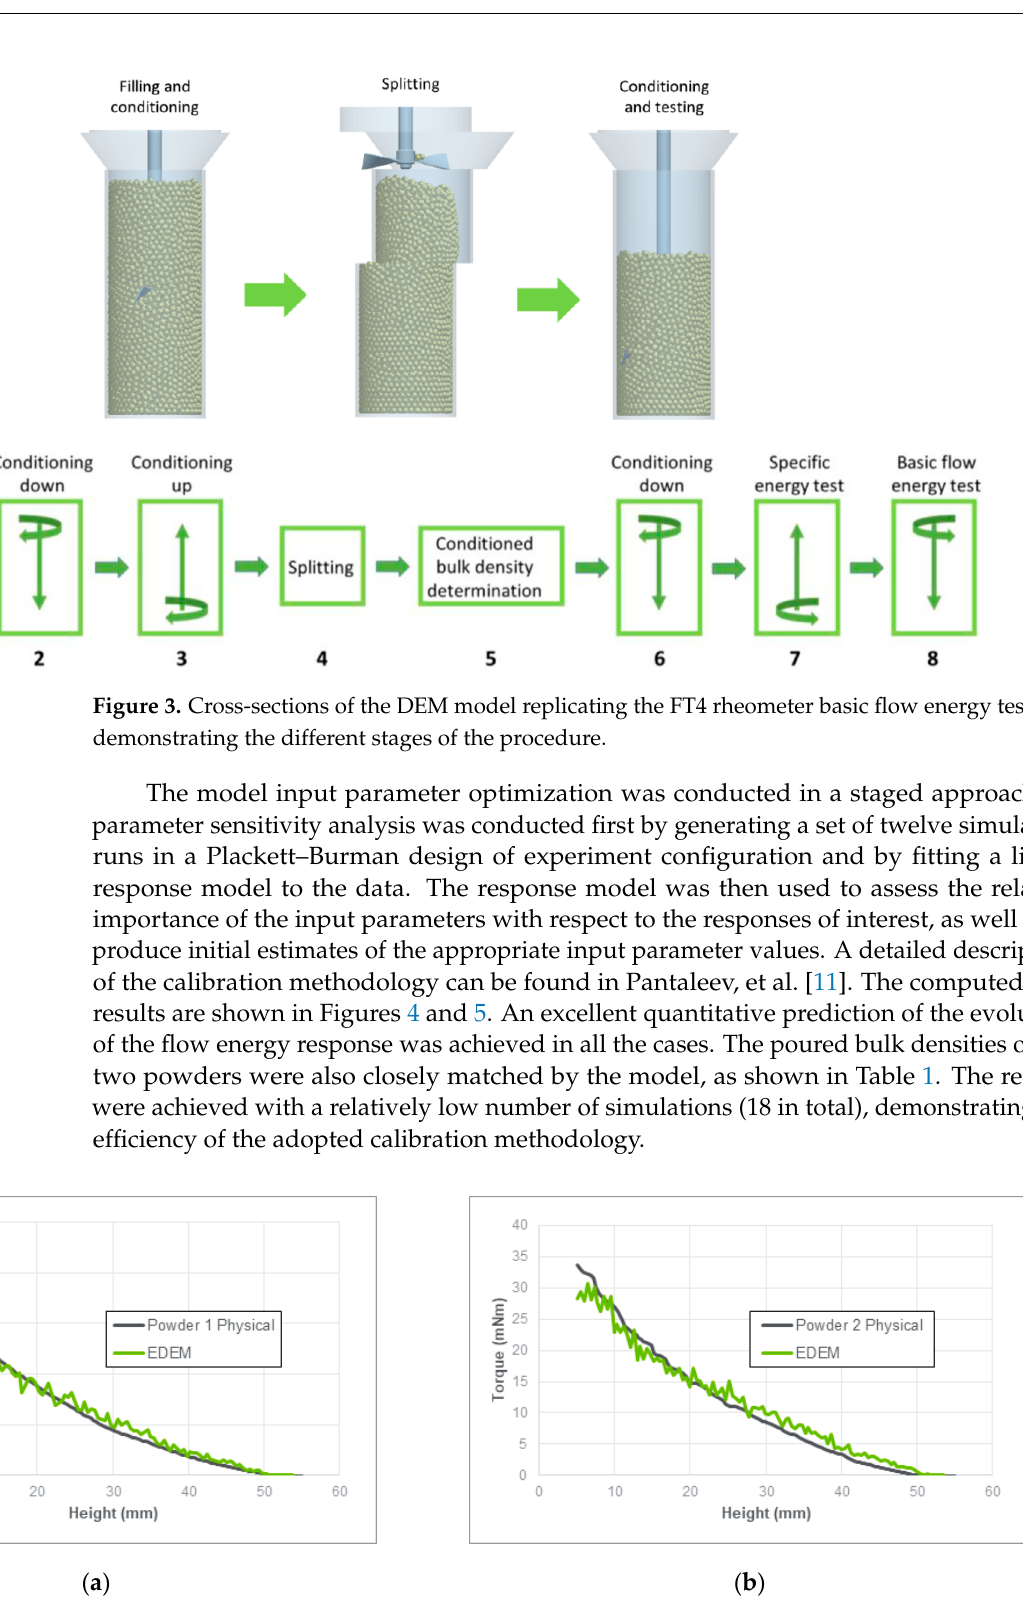
Figure 4. Experimental and simulated torques on the impeller blade during the basic flow energy test cycle at 100 mm/s blade-tip speed for ( a ) free-flowing powder and ( b ) cohesive powder.